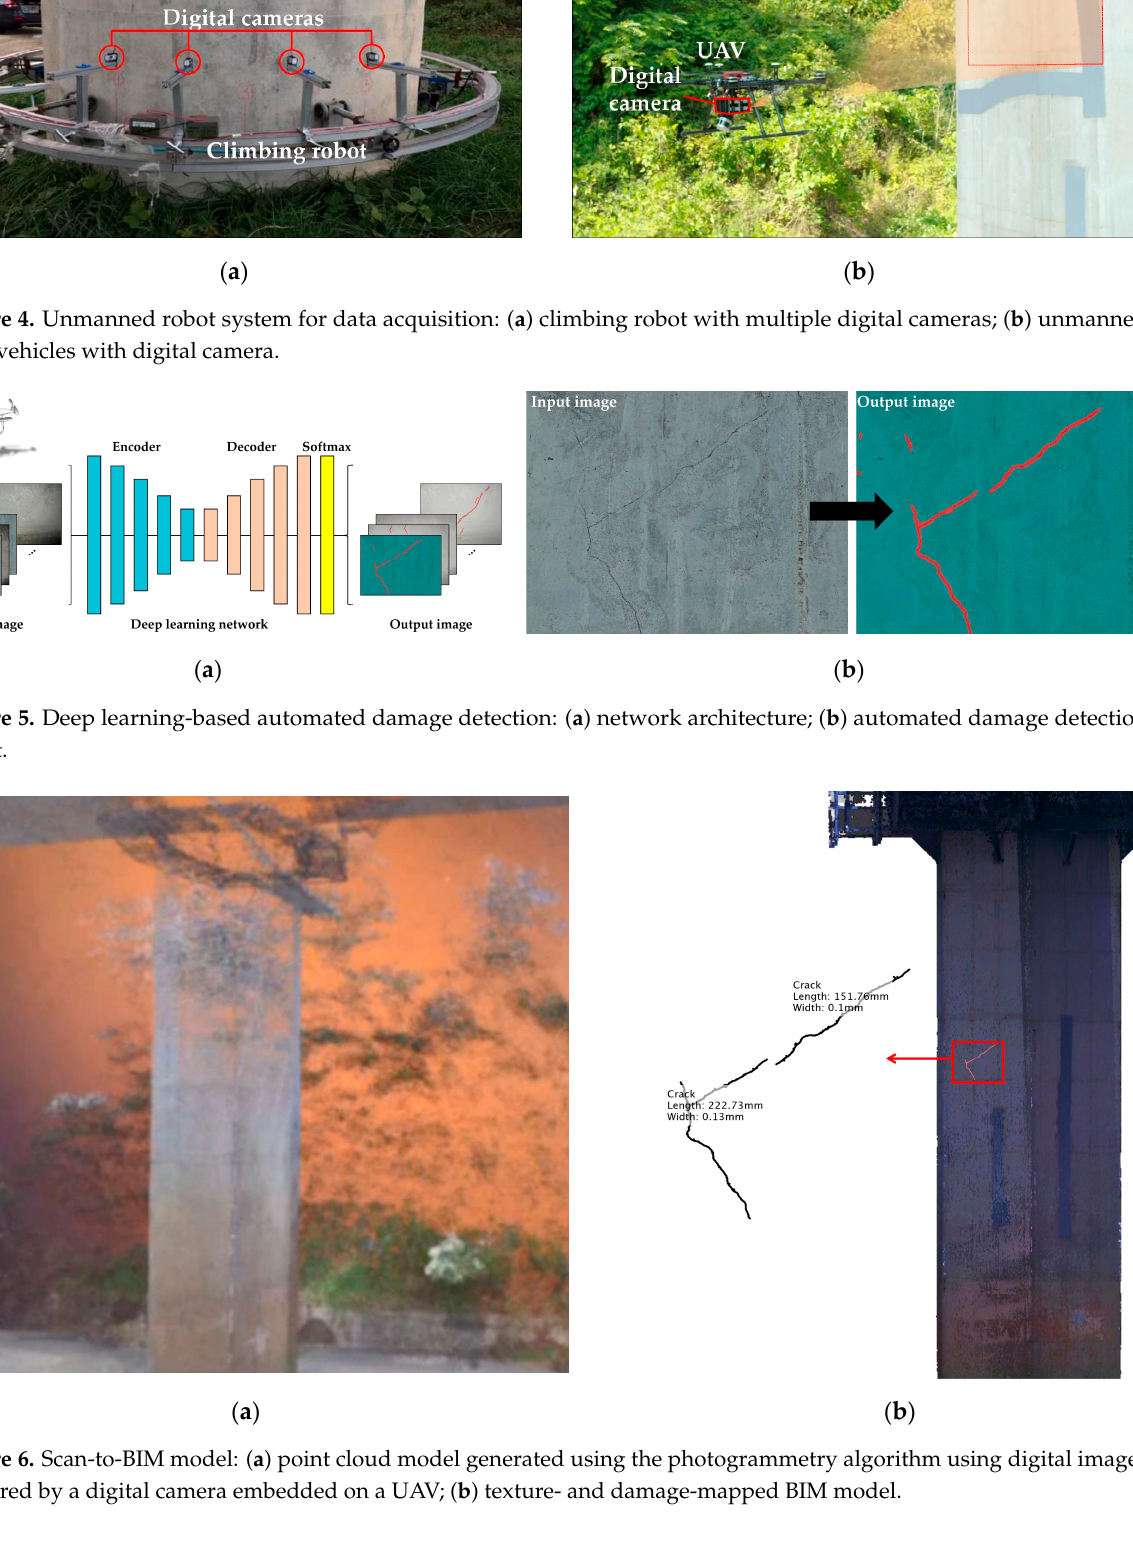
Figure 4. Unmanned robot system for data acquisition: ( a ) climbing robot with multiple digital cameras; ( b ) unmanned arial vehicles with digital camera.